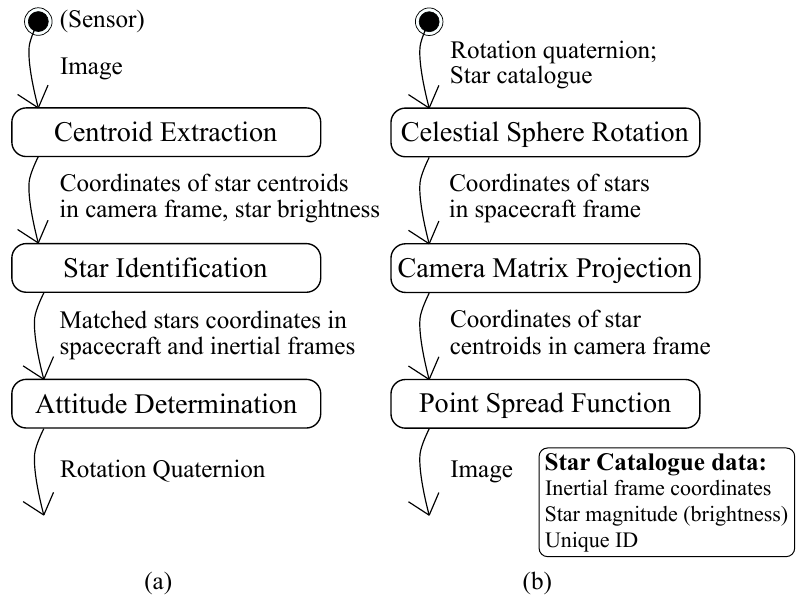
Figure 3. ( a ) Star tracker software input and output; and ( b ) star simulator stages. The boxes indicate the software components, and the arrows indicate the data flow between